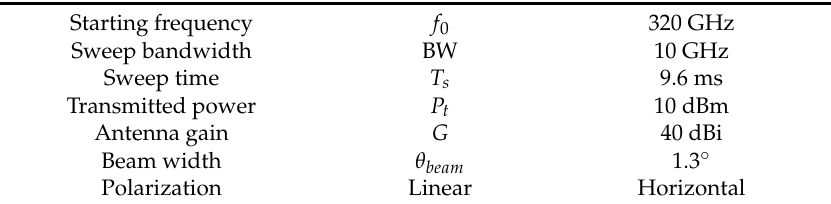
Table 2. 320–330 GHz FMCW radar parameters.